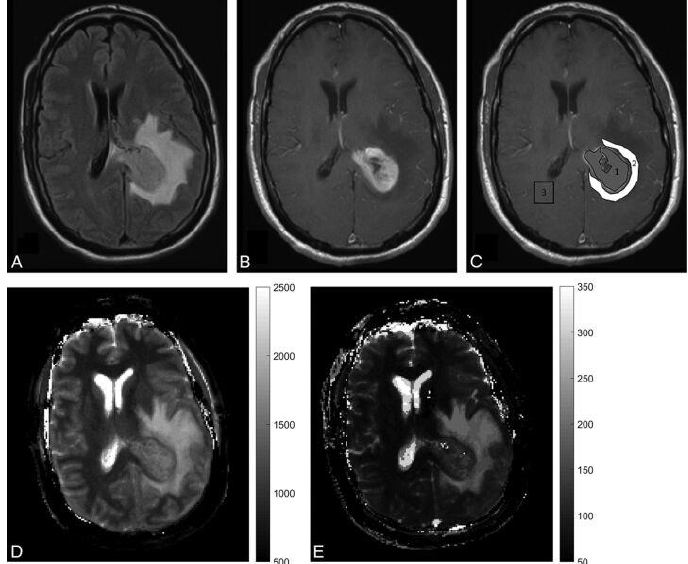
Figure 3. A 45-year-old male presenting with severe headaches and altered sensorium was later diagnosed with glioblastoma. ( A , B ) are FLAIR- and contrast-enhanced T1-weighted images from the clinical scan, which demonstrate a left parietal enhancing lesion with peritumoral FLAIR hyperintensity. ( C ) is a post-contrast T1-weighted image with ROI overlay. 1 shows a solid enhancing tumour region, while 2 shows a peritumoral white matter region. 3 in contralateral hemisphere denotes the contralateral white matter measurement. ( D , E ) are MRF-derived quantitative T1 and T2 maps showing a wider extent of disease. Reprinted with permission from ref. [40]. Copyright 2020 American Journal of